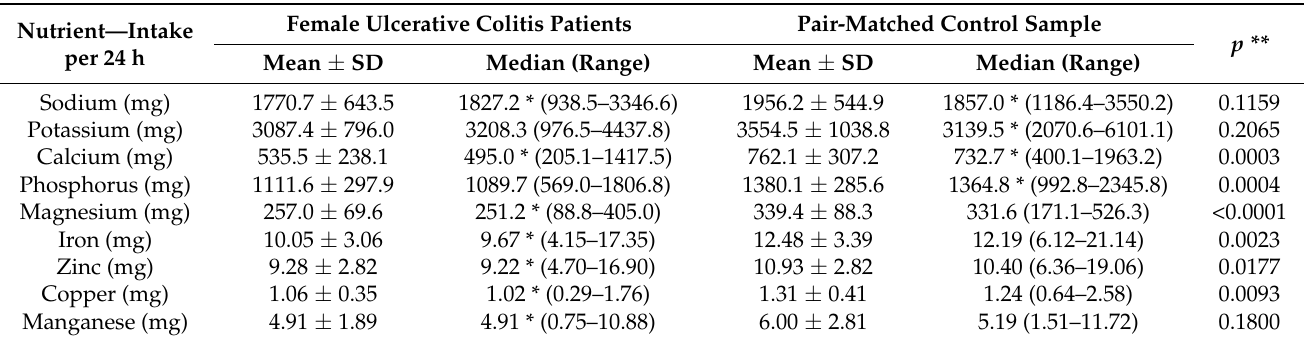
Table 3. The minerals intake in the studied Polish female ulcerative colitis individuals, in comparison with a pair-matched control sample.